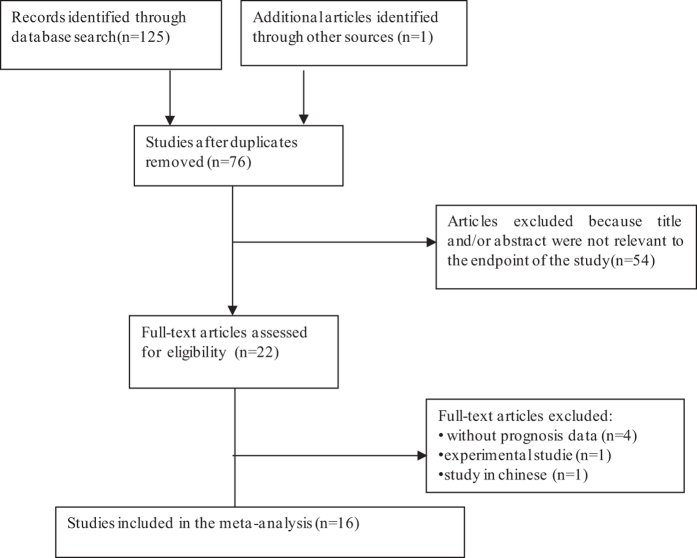
The flow chart of the selection process in our meta-analysis.